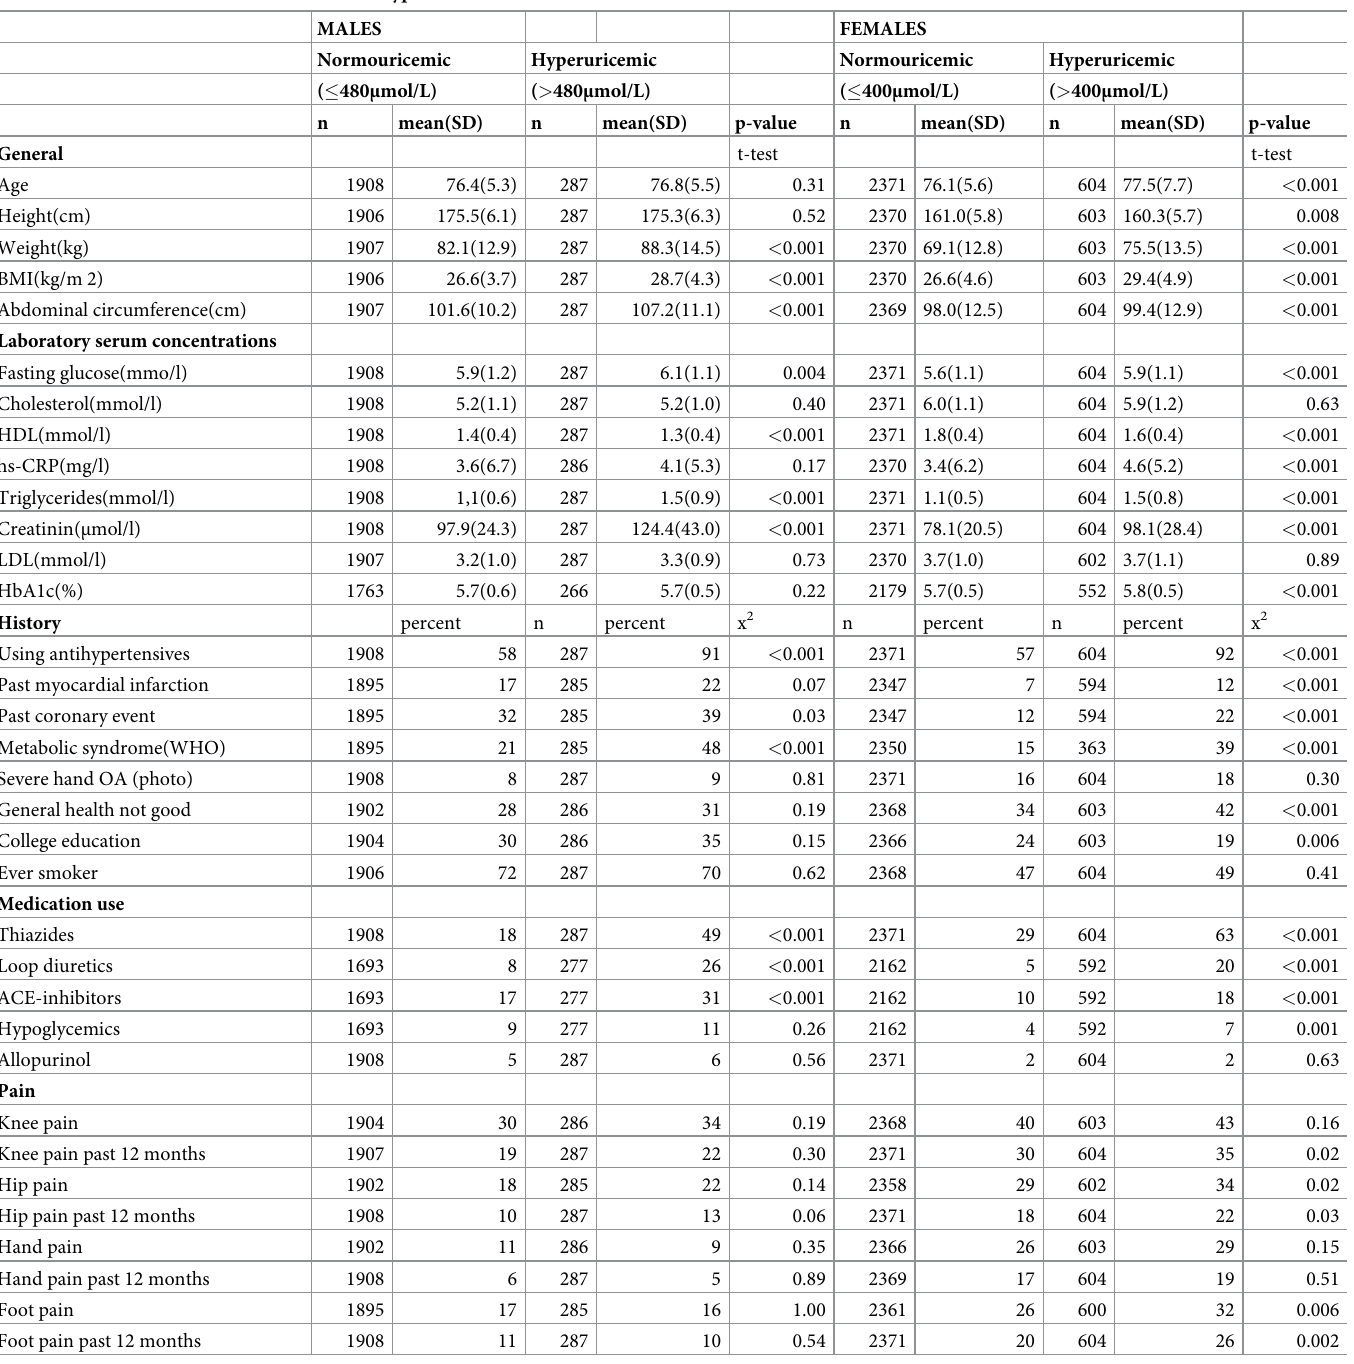
Table 1. Baseline characteristics in relation to